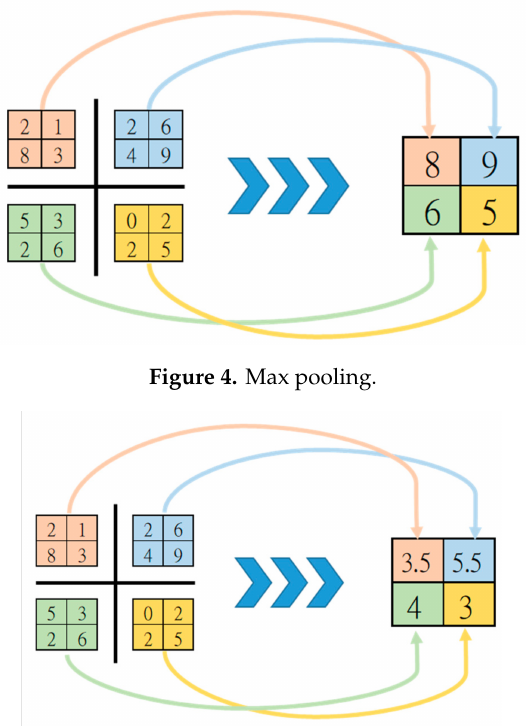
Figure 5. Average